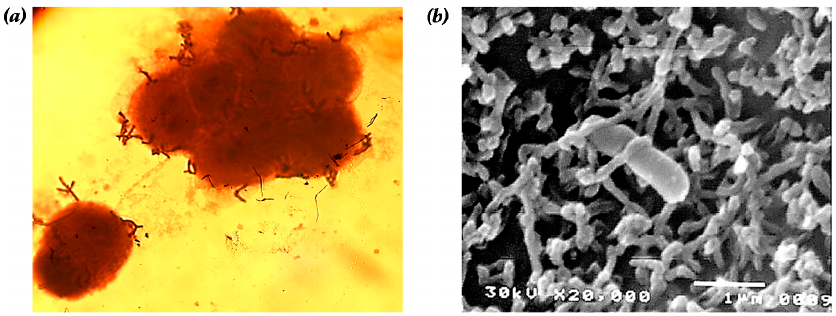
Figure 1. Adhesion of B. bifidum BGN4 onto the epithelial Caco-2 cell observed by: ( a ) optical (magnification of 1000×); and ( b ) scanning electron microscopy (magnification of 20,000×, interaction with microvilli of Caco-2 and B. bifidum BGN4). Microbial adherence in ( a ) was observed after simple staining with crystal violet. Panel ( b ) was adapted from Kim et al. [26].